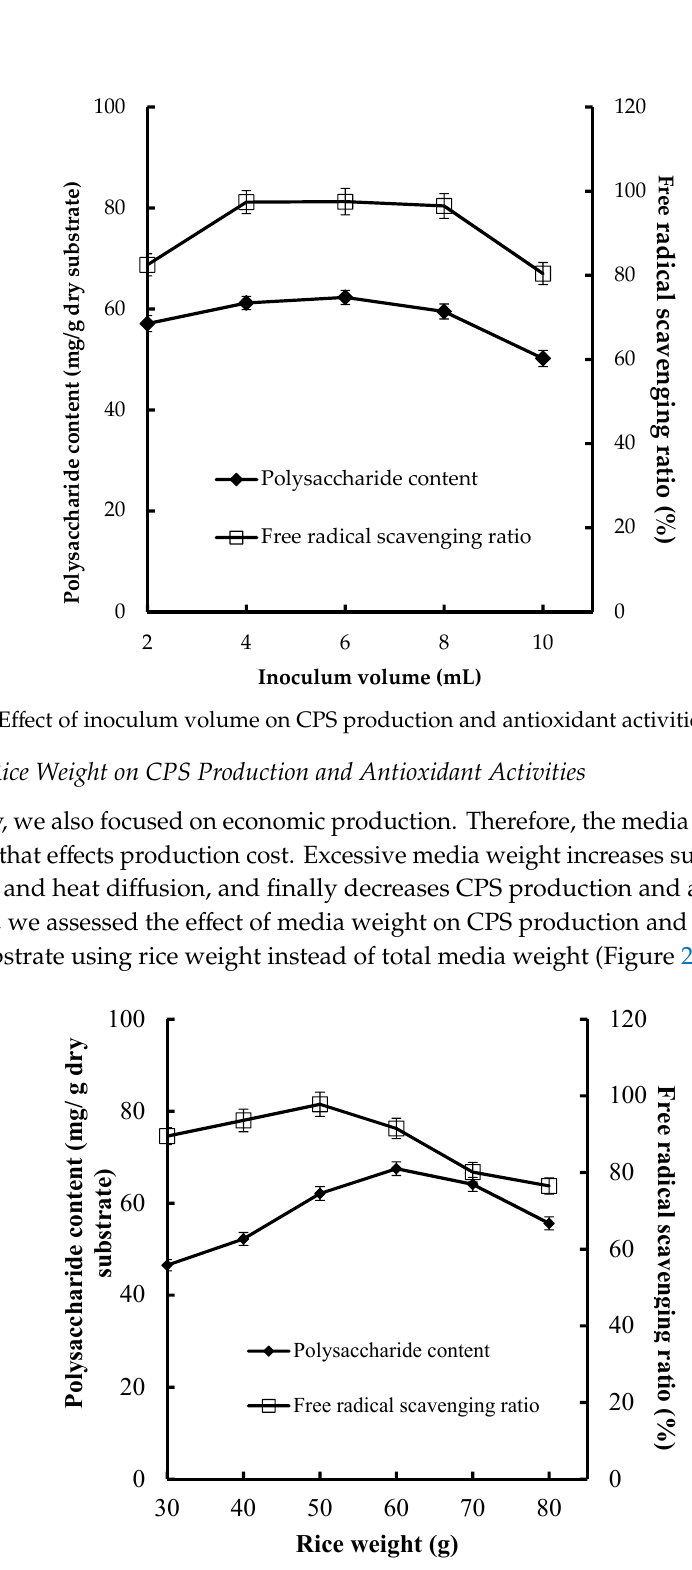
Figure 3. Effect of incubation temperature on CPS production and antioxidant activities of substrate.